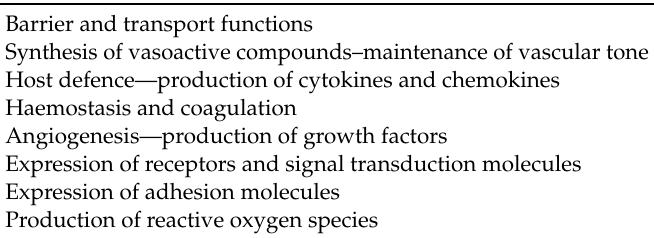
Table 1. Major pulmonary endothelial